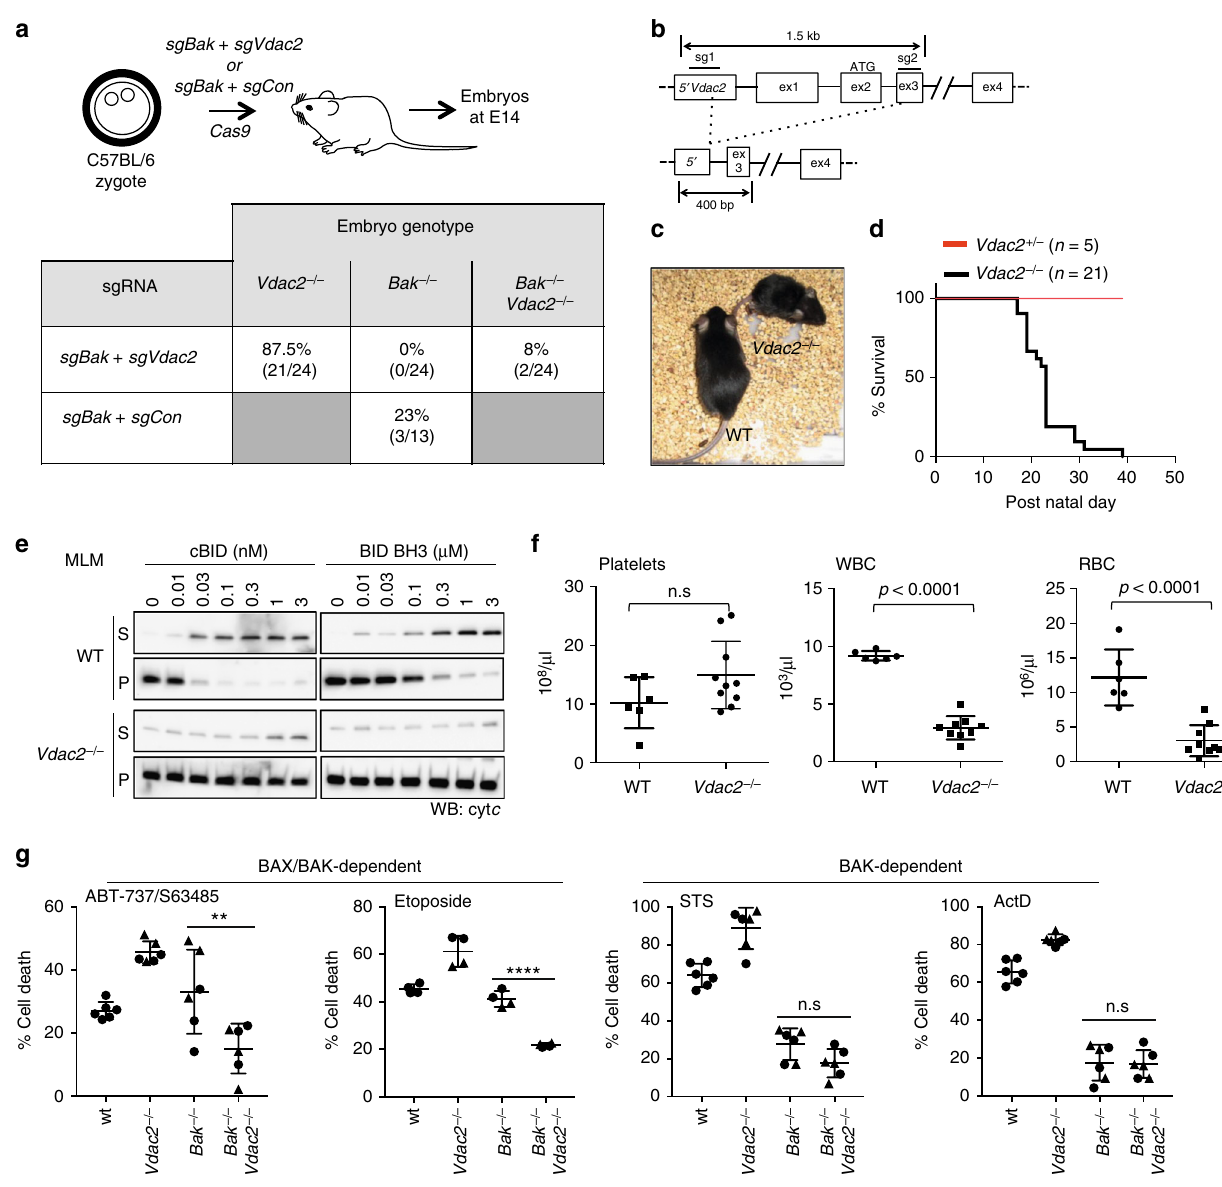
Fig. 4 Vdac2 − / − mice do not show evidence of excessive BAK activity. a Bak deletion is not essential for early embryonic development of Vdac2 − / − mice. C57BL/6J zygotes were injected with DNA encoding Cas9 and sgRNAs targeting Bak and Vdac2 (or Rosa as a control) and transplanted into pseudo- pregnant mothers. The percentage embryos at E14.5 with homozygous null alleles are indicated (number of mice in parentheses). (b) Gene targeting strategy to generate Vdac2 − / − mice. Targeting by both sgRNAs will result in a deletion of 500 bp whereas targeting by the 3 ’ sgRNA alone results in indels (see Supplementary Fig. 3a). c , d Vdac2 − / − mice are runted die post-natally. Kaplan – Meier survival curve of Vdac2 + / − and Vdac2 − / − F0 mice. e Vdac2 − / − mitochondria are resistant to MOM permeabilization. Liver mitochondria isolated from age-matched WT and Vdac2 − / − mice were treated with cBID prior to fractionation into supernatant (S) and membrane (P) and immunoblotting for cytochrome c . Data are representative of N = 2 mice (see Supplementary Fig. 3d). f Vdac2 − / − mice show defects in the hematopoietic system. Blood counts for individual age-matched wild-type (WT, N = 6) or Vdac2 − / − ( N = 9) mice shown with mean + / − SD. WBC white blood cells, RBC red blood cells. P values calculated by two-tailed Student ’ s t -test. n.s, not signi fi cant. g Early passage primary Bak − / − (BR1.4, triangles; BR2.1, circles ), Vdac2 − / − (BV1.1, triangles; BV2.4, circles ), Bak − / − Vdac2 − / − (BV2.1, triangles , BV2.3, circles ) or wild- type (wt, circles ) MEFs (see Supplementary Figure 8) were treated with etoposide (10 μ M), ABT-737 (1 μΜ ) and S63485 (1 μ M), staurosporine (STS, 1 μ M) or actinomycin D (ActD, 1 μ M) and cell death assessed by PI uptake after 24 h. Data is mean + / − SD of three independent experiments. ** p < 0.01; **** p